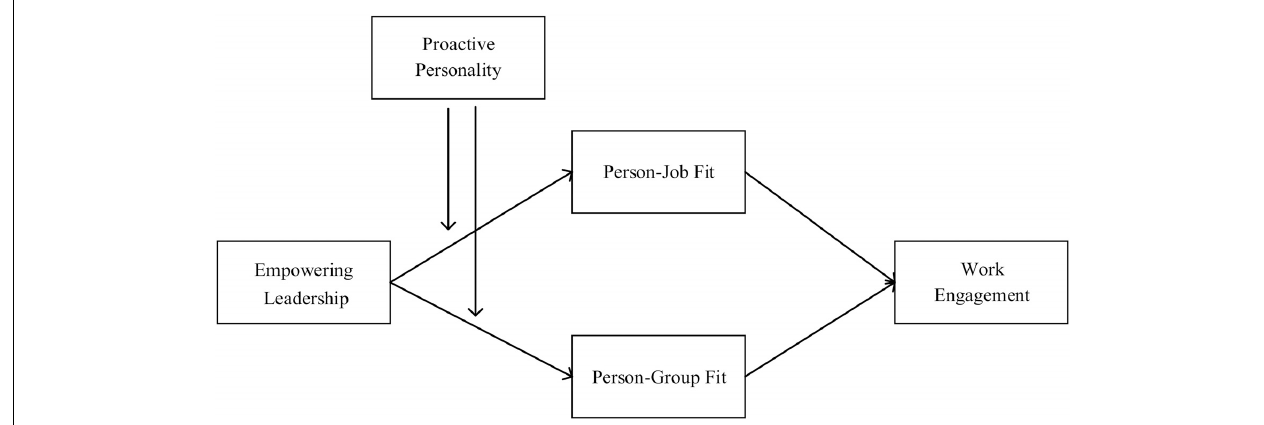
FIGURE 1 | Concept